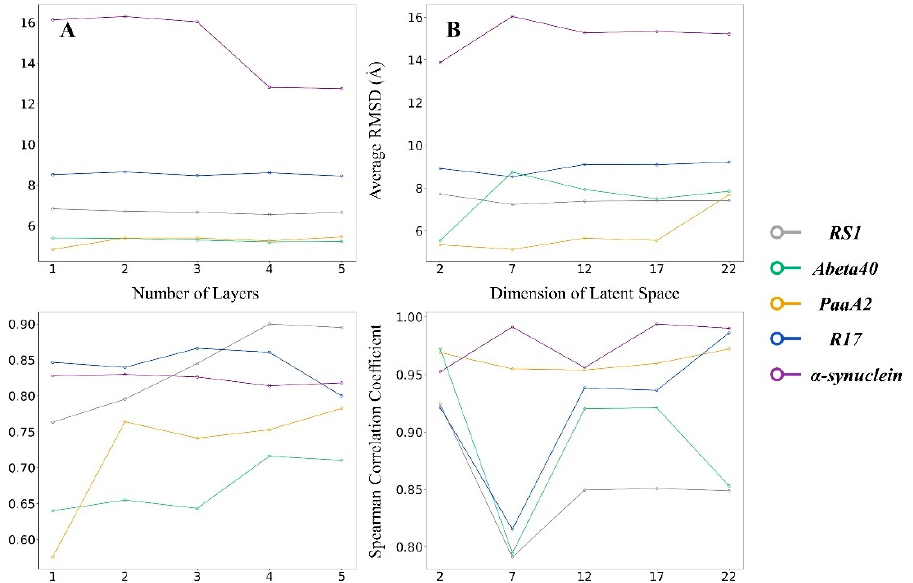
Figure 2. Average RMSD and Spearman correlation coefficient between IDP conformations generated by VAEs of different structures and corresponding MD trajectories. ( A ) RMSDs and Spearman correlation coefficients on VAEs of different layers (1 to 5 layers at 1 interval). ( B ) RMSDs and Spearman correlation coefficients on VAEs whose latent spaces are different sizes. (2 to 22 dimensions at 5 intervals).